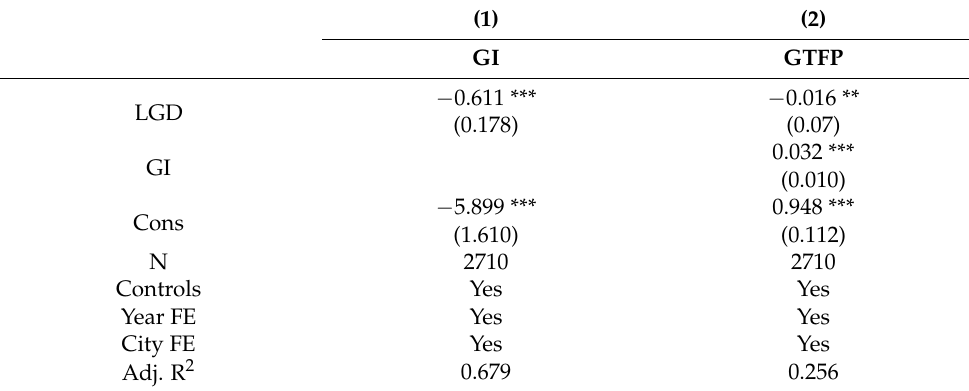
Table 5. Mediating effects test.